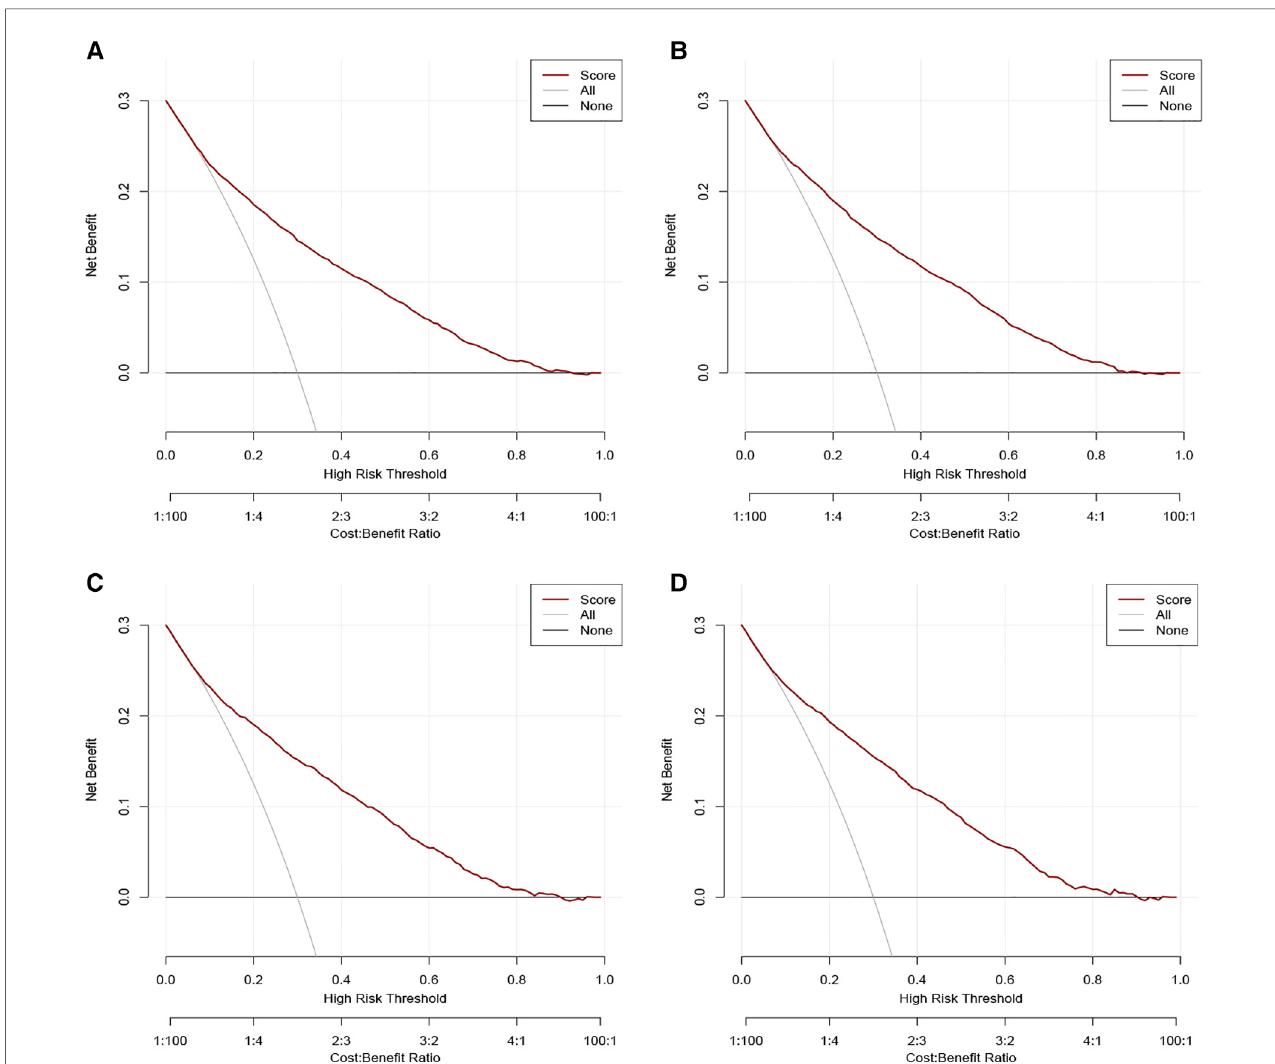
FIGURE 4 Decision curve analysis (DCA) for the nomograms in predicting all-cause and cancer-speci fi c early death in the training cohort ( A,B ) and the validation cohort ( C,D